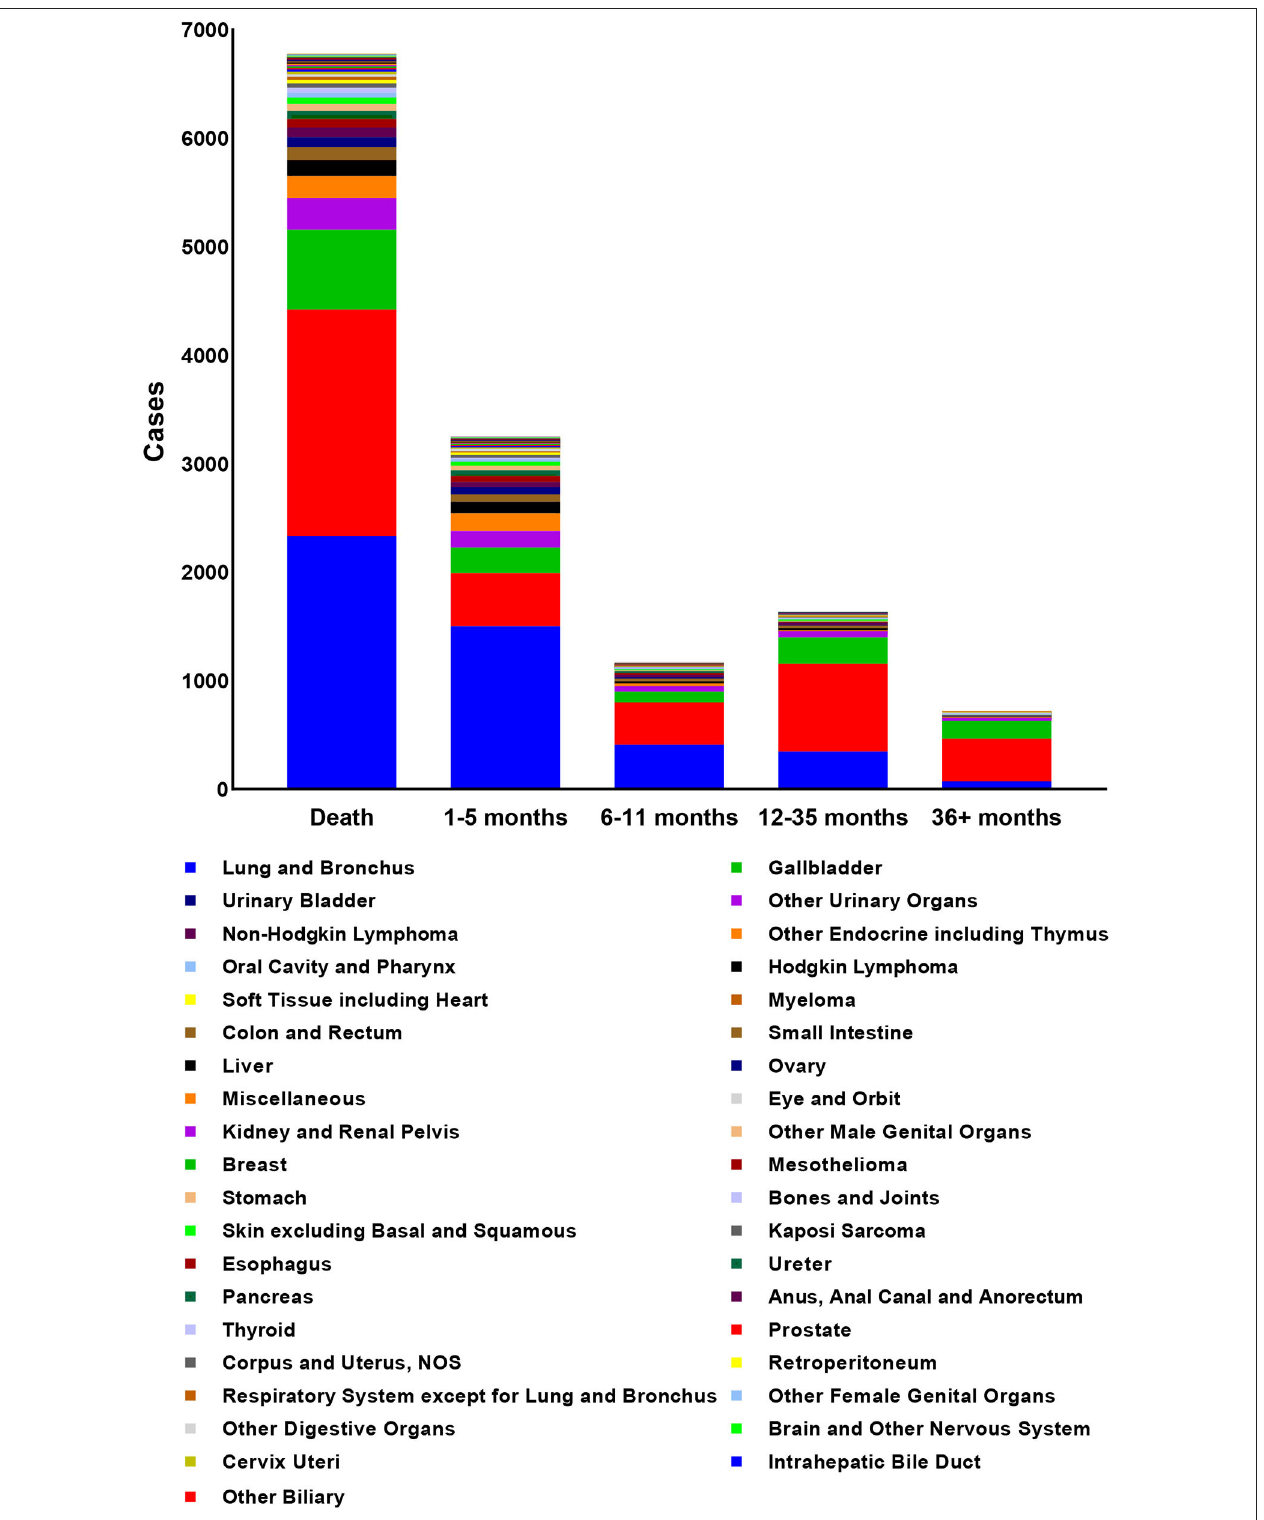
FIGURE 2 | The deaths among different primary cancers and different death latencies.